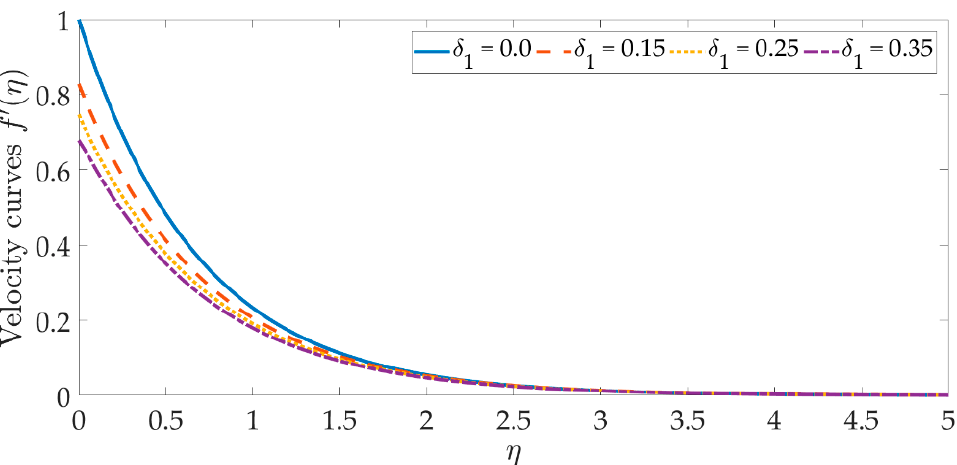
d Figure 5. Velocity curves against the multiple values of δ